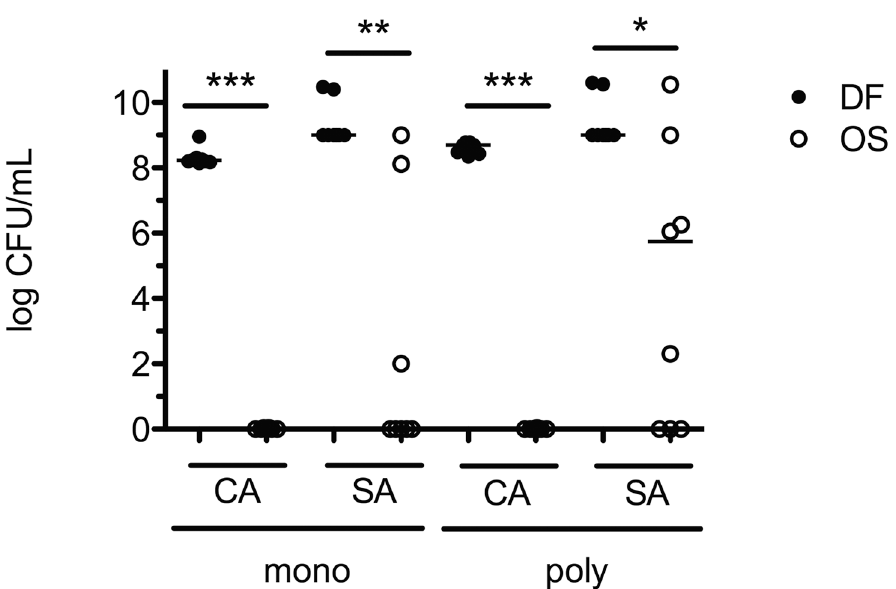
Fig 7. Polymicrobial regrowth after treatment with OS 1. Regrowth of mono- and polymicrobial biofilms on silicone disks after treatment with optimized lock solution. Monomicrobial (CA, SA) and polymicrobial (CA +SA) biofilms of C . albicans and S . aureus were challenged with drug free (DF, closed circles) or optimized solution (OS 1, 20% ethanol, 800 μ g/mL doxycycline, and 0.015625 μ g/mL micafungin, open circles) prepared in sterile growth medium for 24 hours. Immediately following lock solution treatment, disks were briefly sonicated and cultured in selective liquid medium for 24 hours. Serial dilutions were plated onto selective medium to quantify microbial regrowth. Horizontal line in dataset represents the median. Data is cumulative of four independent experiments performed in triplicate. * , P (cid:3) 0.05, ** P (cid:3) 0.01, *** P (cid:3) 0.001 using a Kruskal-Wallis one-way ANOVA and Dunn ’ s multiple comparisons